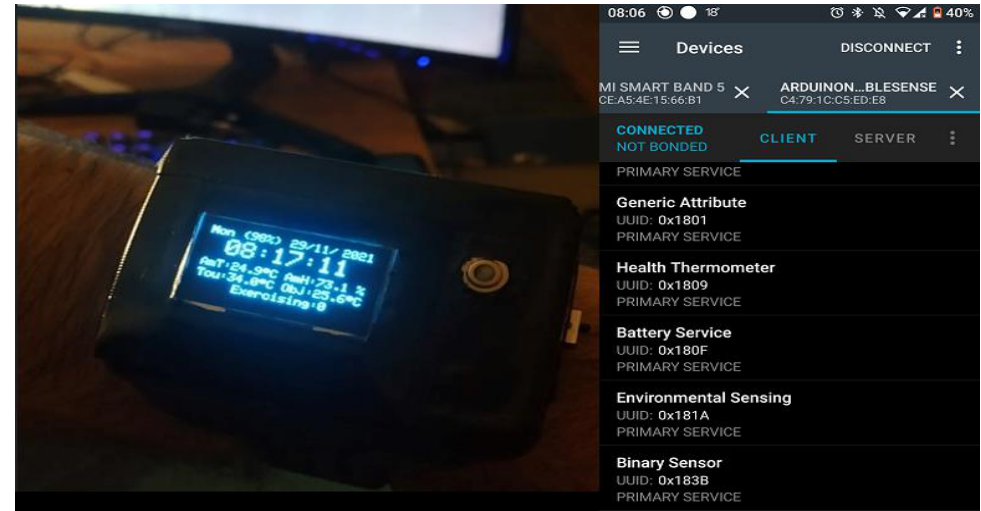
Figure 1 . Wearable prototype and BLE advertised services. Figure 1. Wearable prototype and BLE advertised